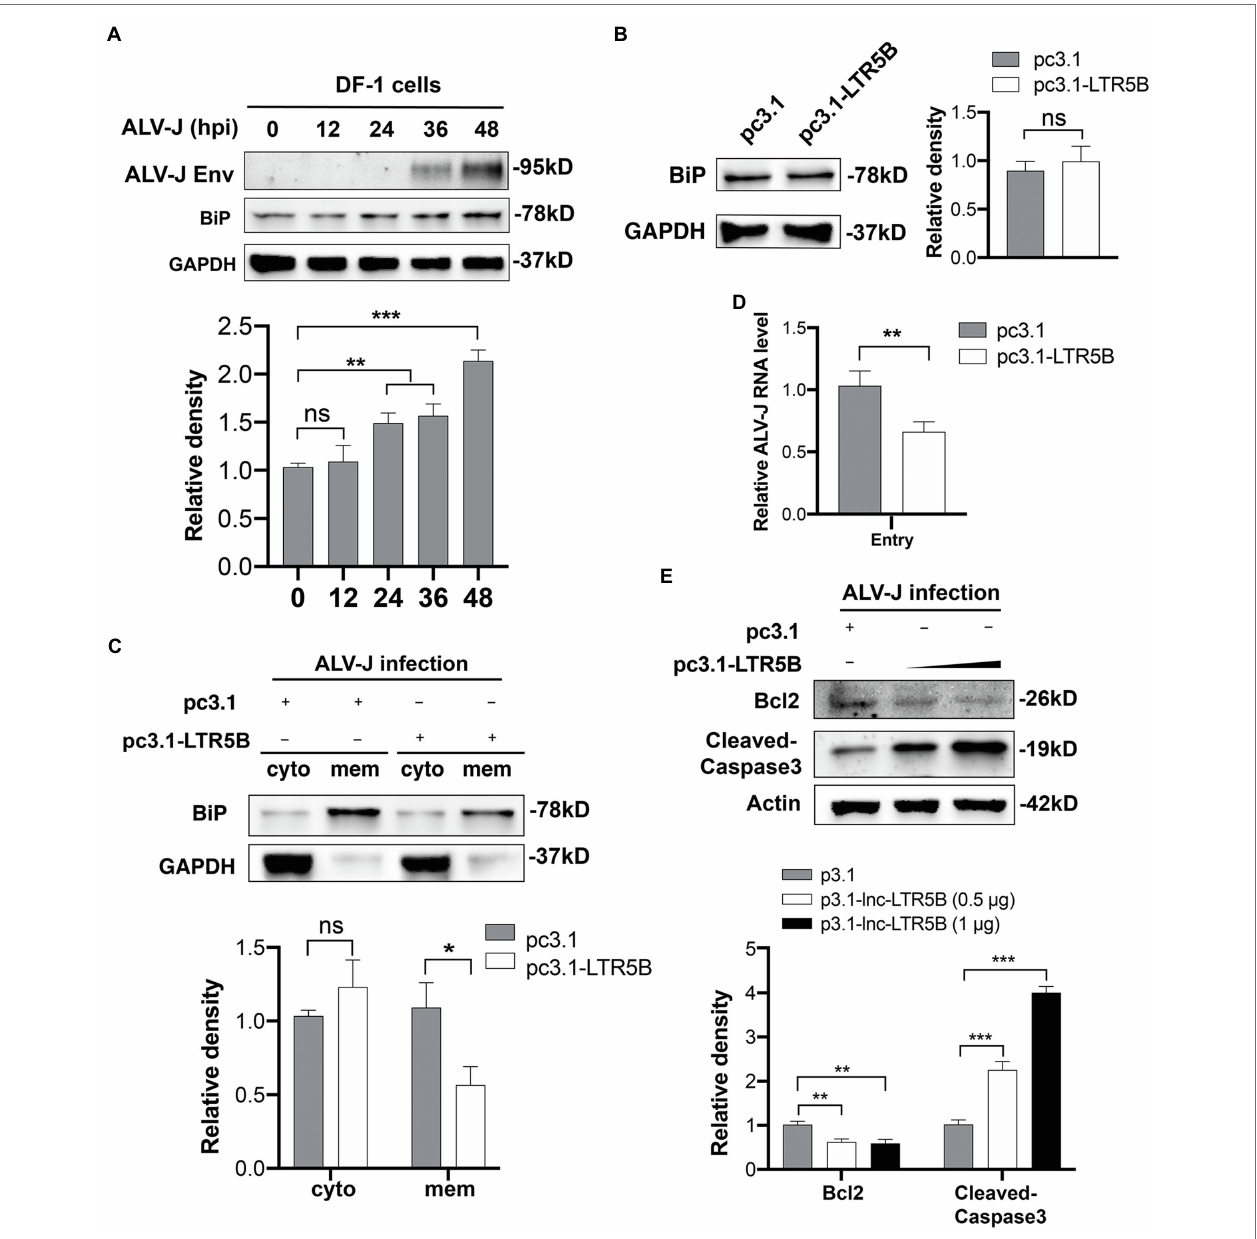
FIGURE 6 | lnc-LTR5B inhibits ALV-J by decreasing surface expression of BiP and promoting apoptosis of infected cells. (A) Western blot analysis of BiP expression in DF-1 cells infected with ALV-J for the indicated time. (B) Western blot analysis of BiP expression in DF-1 cells transfected with either pcDNA3.1-lnc-LTR5B or control vector. (C) Western blot analysis of cell surface distribution of BiP in DF-1 cells transfected with either pcDNA3.1-lnc-LTR5B or control for 24 h, followed by infection with ALV-J at MOI 5 for another 24 h. GAPDH served as markers for the plasma membrane and cytosol fractions. (D) DF-1 cells were transfected with pcDNA3.1-lnc-LTR5B or control vector for 24 h, followed by infection with ALV-J at MOI 20 on ice. At 1 h post-infection, the cells were cultured at 37 ° C for another 1 h. Then, the endocytosed-virus levels were determined by qRT-PCR for ALV-J genomic RNA. (E) Western blot analysis of Bcl2 and cleaved-caspase3 in DF-1 cells transfected with increasing amounts of pcDNA3.1-lnc-LTR5B or control pcDNA3.1, followed by infection with ALV-J at MOI 0.5 for 48 h. The relative intensities of the different protein bands were analyzed and quantified by ImageJ software ( A,C,E , lower panel; B , right panel). Data are presented as mean ± SD, n = 3; * p < 0.05, ** p < 0.01, *** p < 0.001, ns, not significant. Statistical analysis was carried out by one-way ANOVA (A) or two-tailed unpaired Student’s t -test (B,C,E)